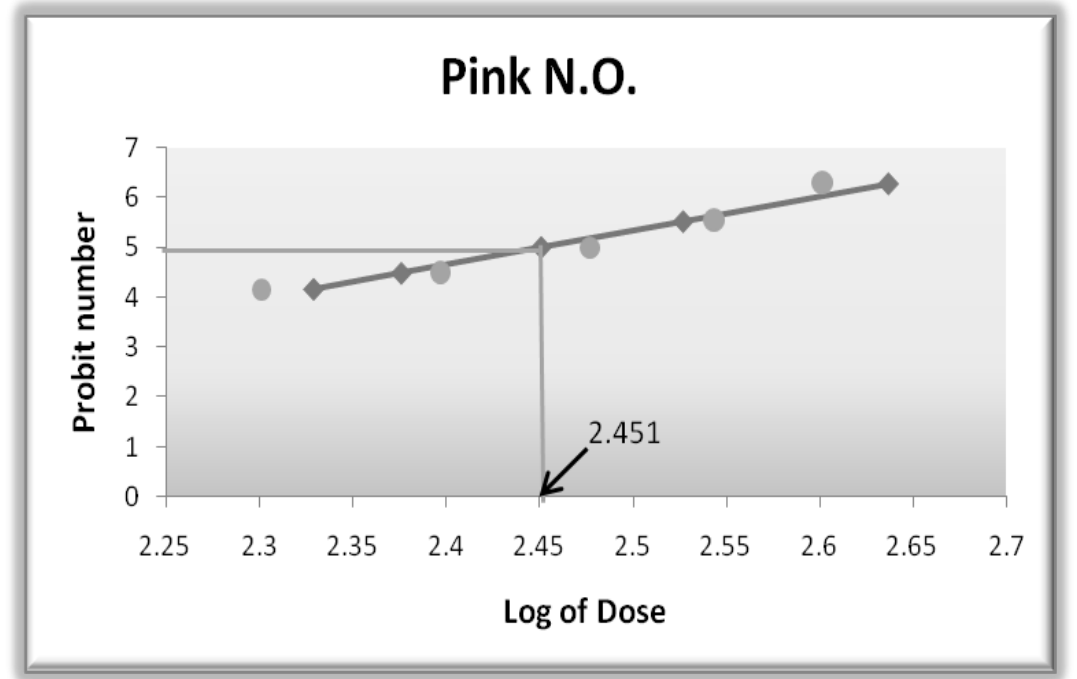
Fig 2:-Estimation log dose-probit curve for hexane extract of the PFG of N.oleander after fitting LD